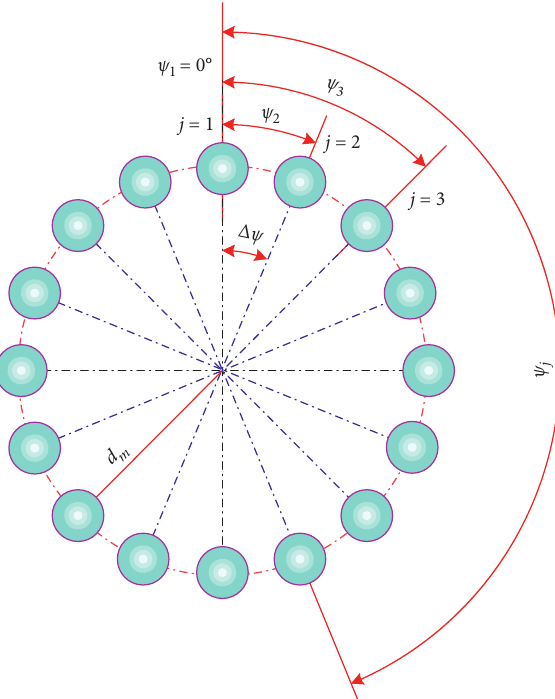
Figure 1: Position map of rolling elements at different azimuth angles ψ j .